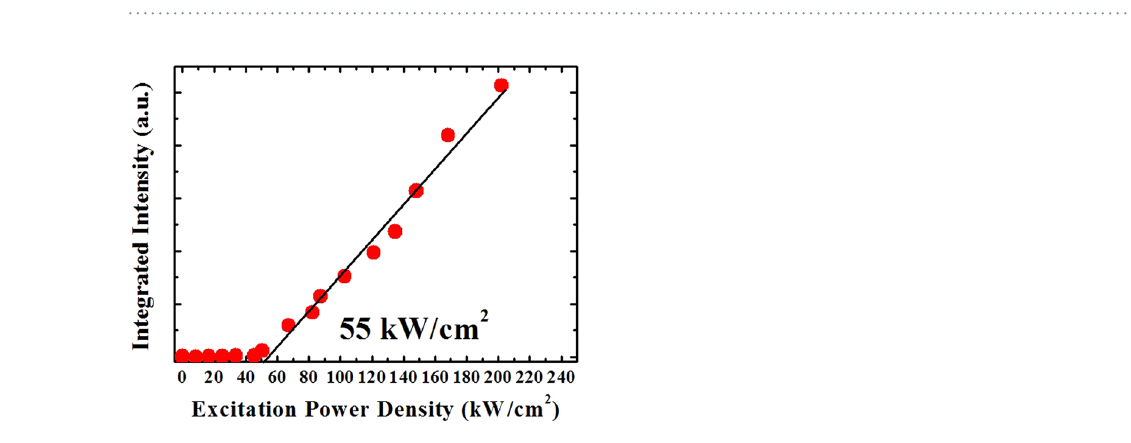
Figure 3. ( a ) Luminescence spectra from the GaN/AlGaN MQW active layer with excitation electron beam power levels of 180, 240, and 280 kW/cm 2 . ( b ) Integrated light intensity of the emission spectra as a function of the excitation electron power density. ( c ) Laser emission spectra of the TE mode and TM mode with excitation electron beam power level of 280 kW/cm 2 .